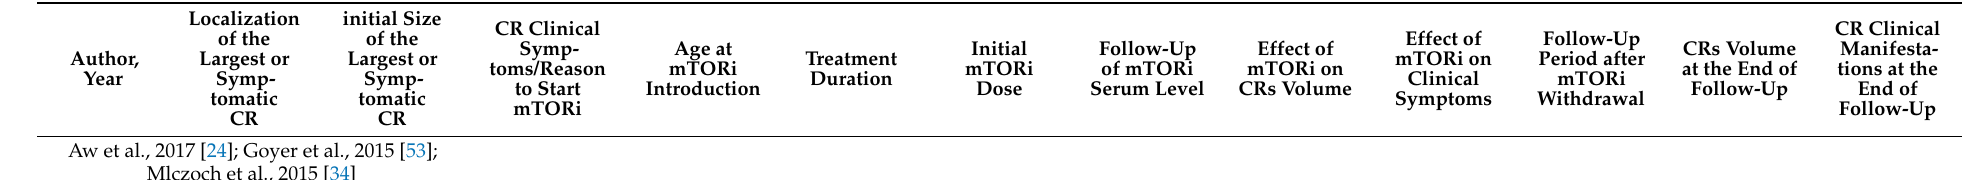
Table 1. Characteristics of children treated with